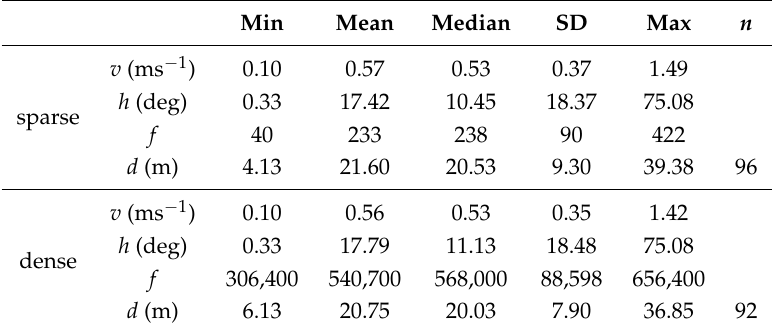
Table 4. Statistical distribution of multiple linear regression model covariates for both sparse and dense visual